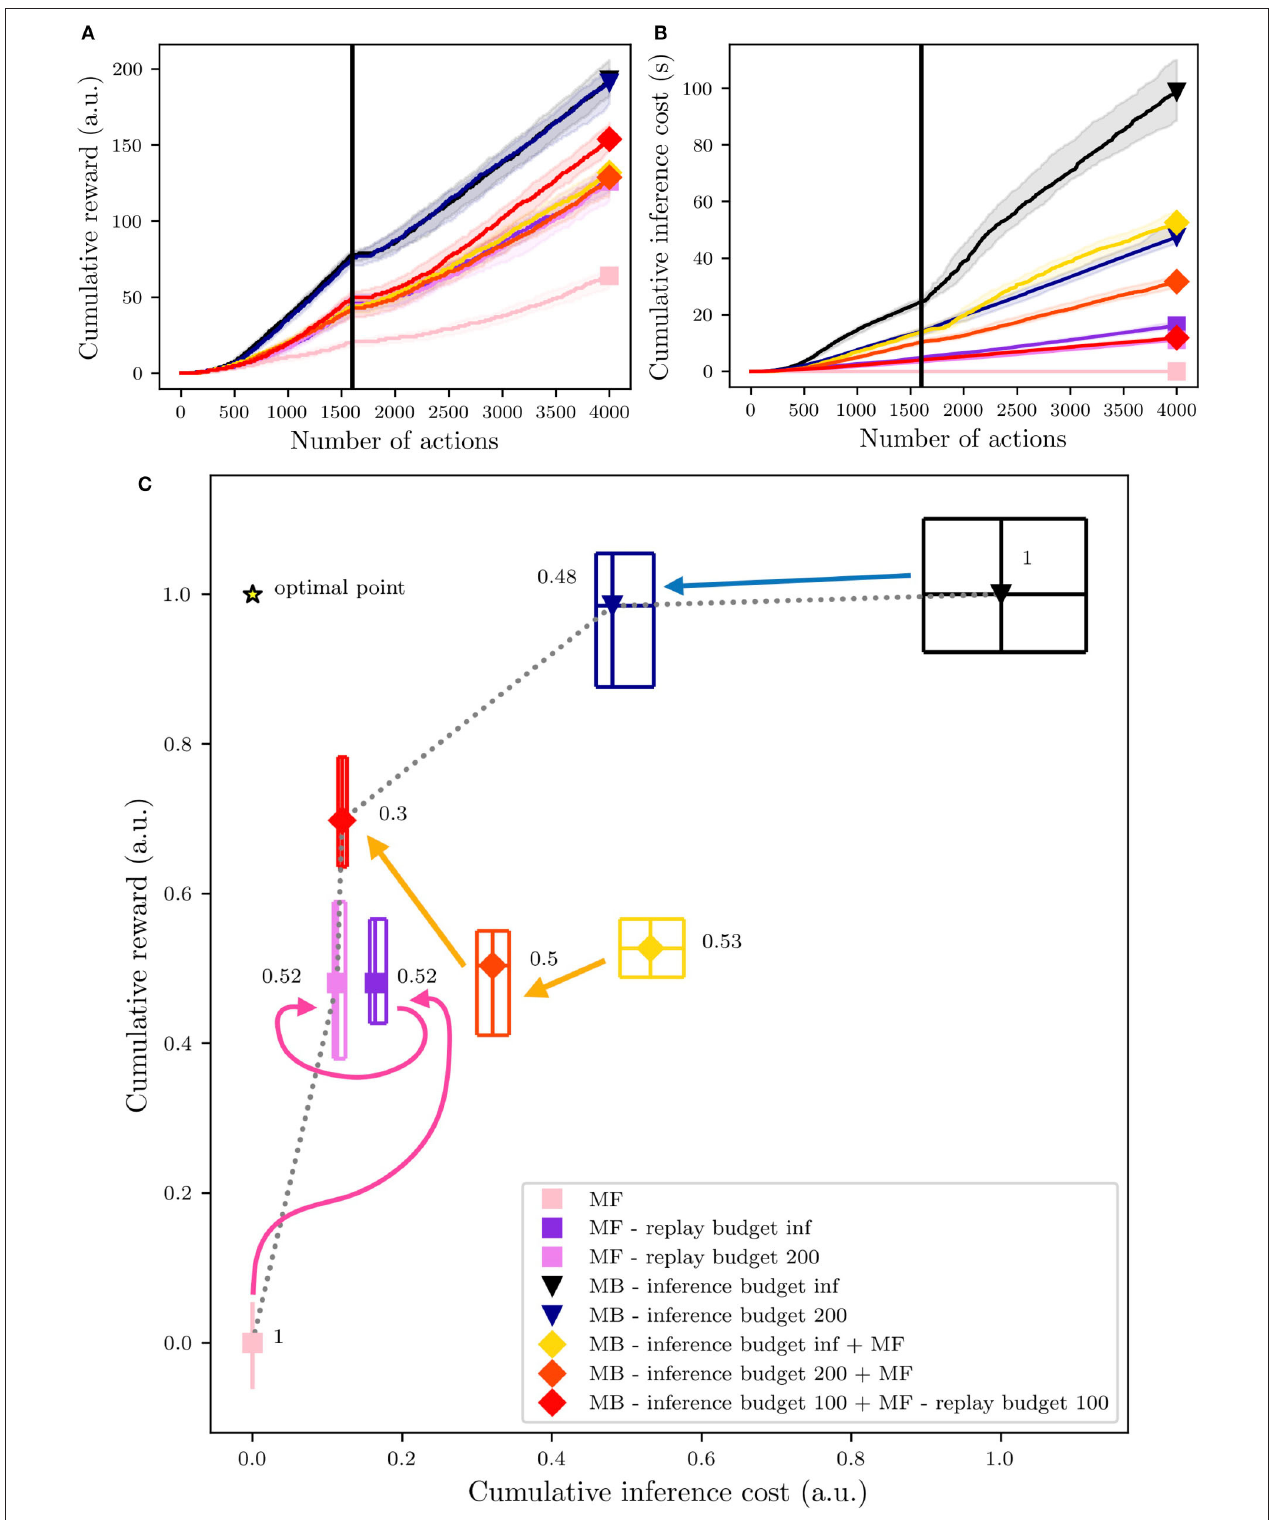
FIGURE 9 | Overall performances of the different agents during their first 4,000 actions in the environment. The vertical black line highlights the trial when the reward switch (1,600). (A) The dynamics of the reward’s accumulation. (B) The dynamics of the computational cost’s accumulation. (C) An overview of the algorithms’ position within a normalized reward × cost space. The central polygons represent the median of the performance over 50 simulated experiments. Cumulative rewards and costs have been normalized considering that the MF medians of the cumulative rewards and costs correspond to 0 and that the MB medians of cumulative rewards and cost correspond to